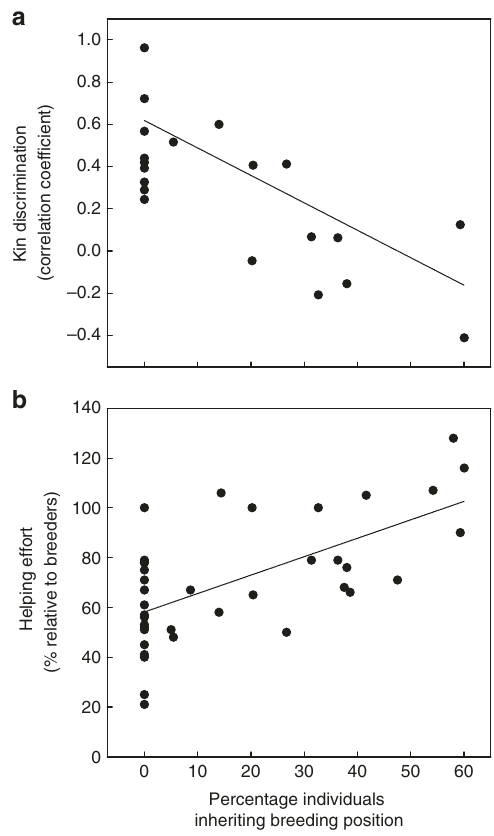
Fig. 2 The likelihood of territory inheritance drives helping decisions in cooperatively breeding birds. a In cooperative breeding bird species, helpers with a high likelihood of inheriting their resident territory do not invest more in more related offspring (low levels of kin discrimination), whereas when prospects of territory inheritance are limited, subordinates mainly direct help towards related offspring (PGLS model: n = 20 species, P = 0.0001; model output is provided in Supplementary Table 3). b Therefore, helpers provision offspring on average more (mean % offspring food provisioning per helper, relative to breeders) when the probability of inheriting their resident territory is larger (PGLS model: n = 38 species, P < 0.0001; model output is provided in Supplementary Table 4). Dots re fl ect species averages, and model-predicted regression lines are plotted